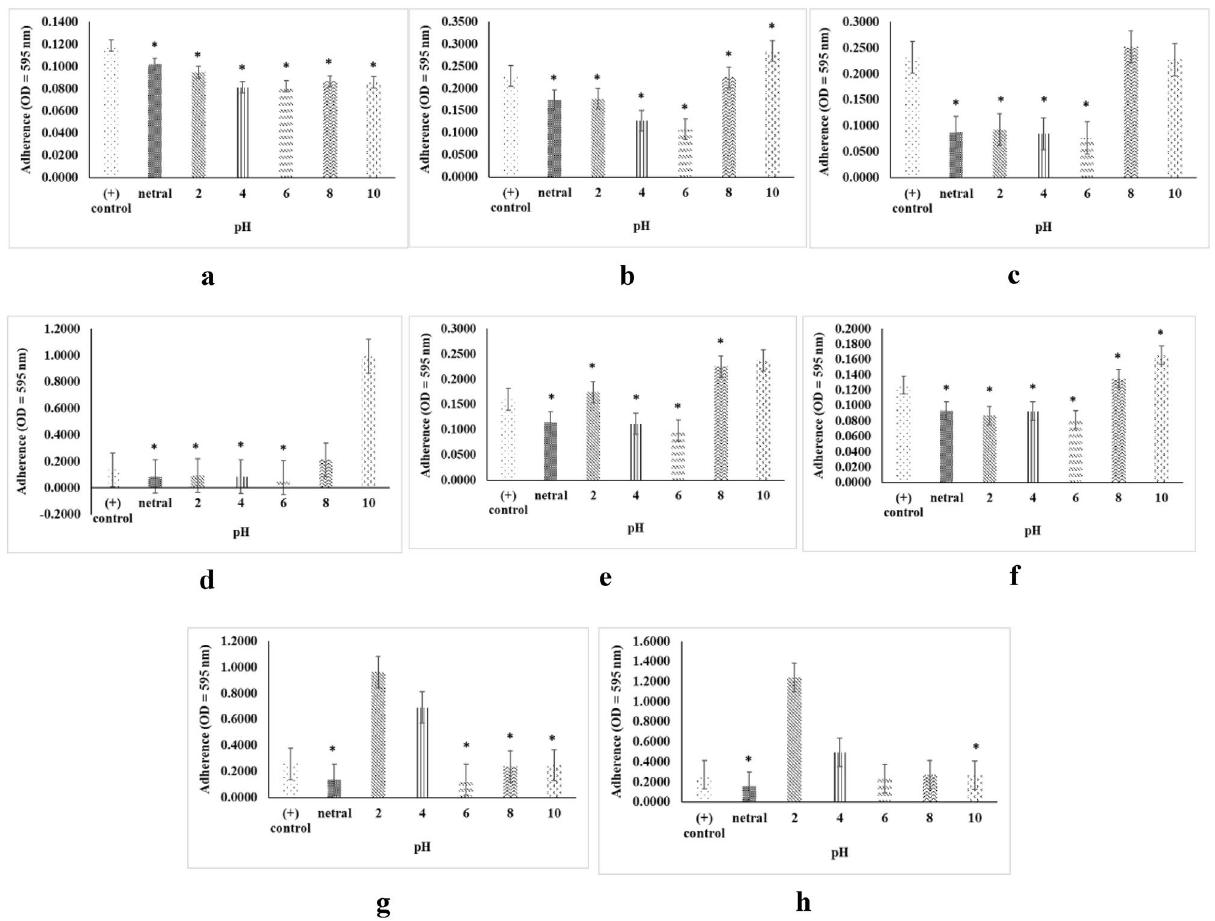
Figure 5. Stability of inhibition activity ( a ) 16PM, ( b ) 20PM, ( c ) 18PM, ( d ) 1AC and destruction activity (e) 16PM, ( f ) 20PM, ( g ) 18PM, and ( h ) 1AC (n = 6 replications; vertical bars are standard errors; *: significantly different at p <